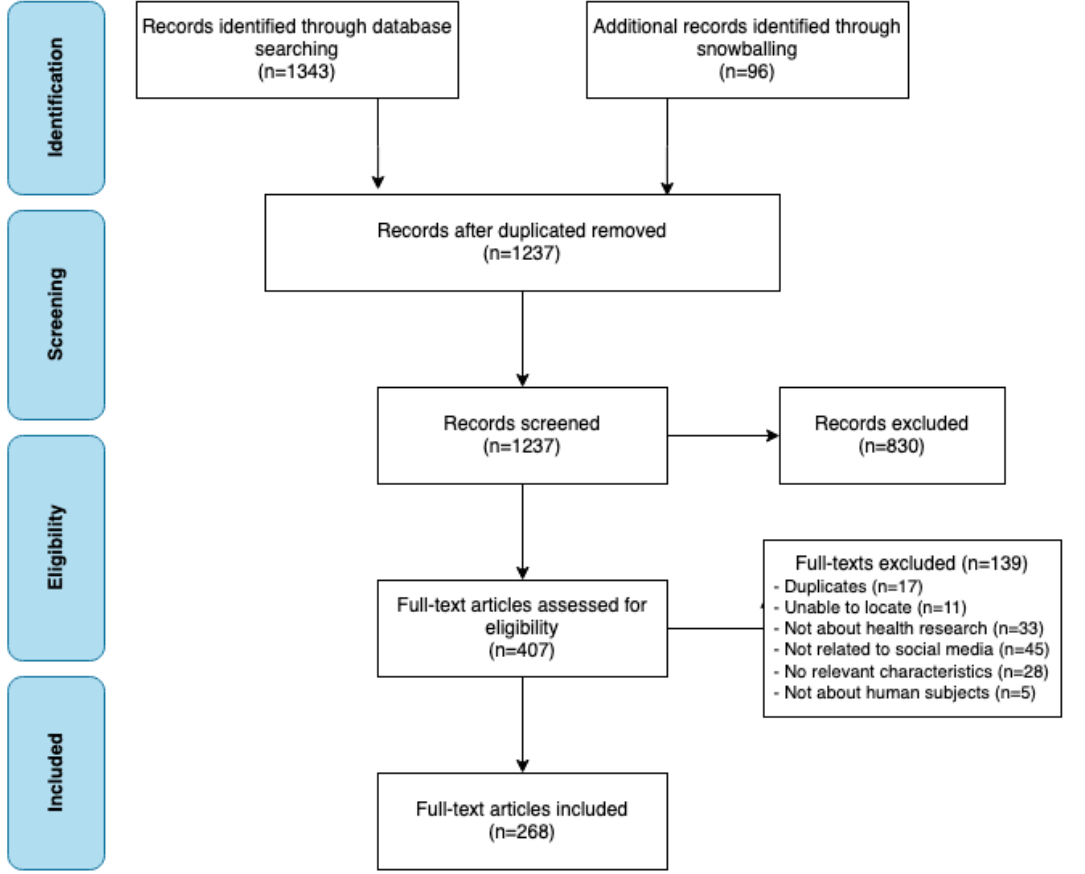
Figure 1. Flow diagram of the included